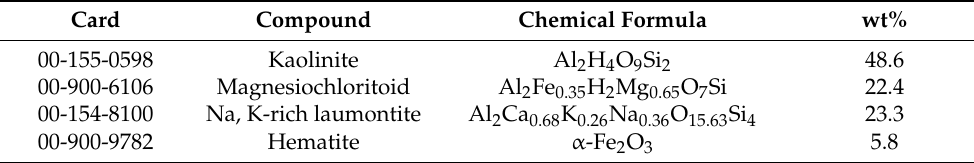
Figure 2. Diffractogram of the red clay sample. Kaolinite (K); hematite (H); magnesiochloritoid (M); and Na, K-rich laumontite (L). Table 2. The red clay diffractogram qualitative